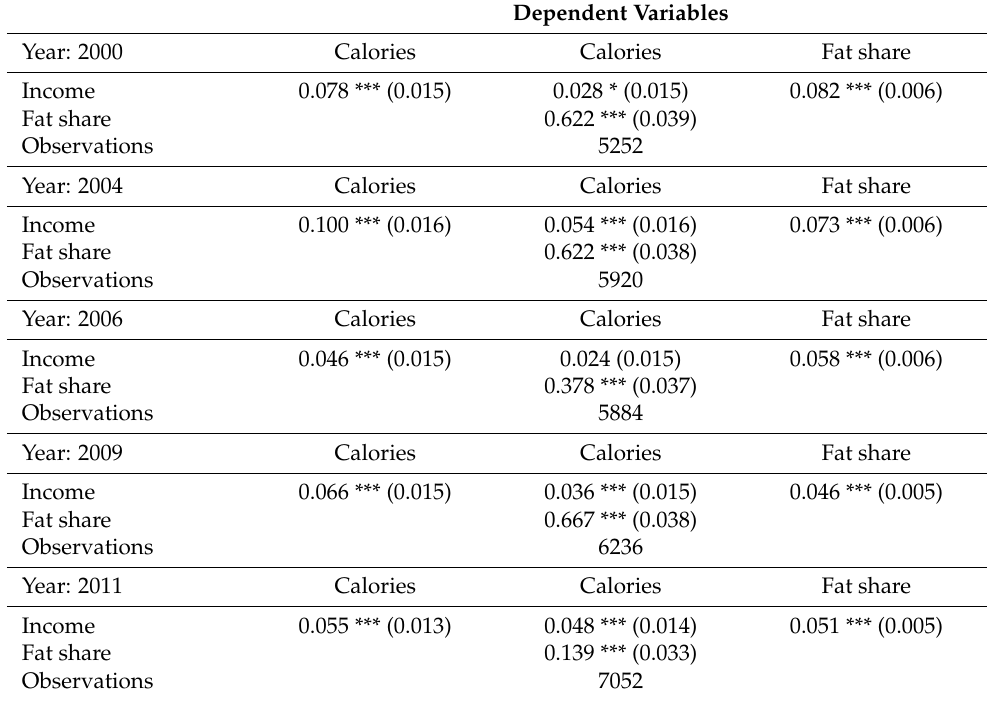
Table A1. The effect of income on calorie consumption among